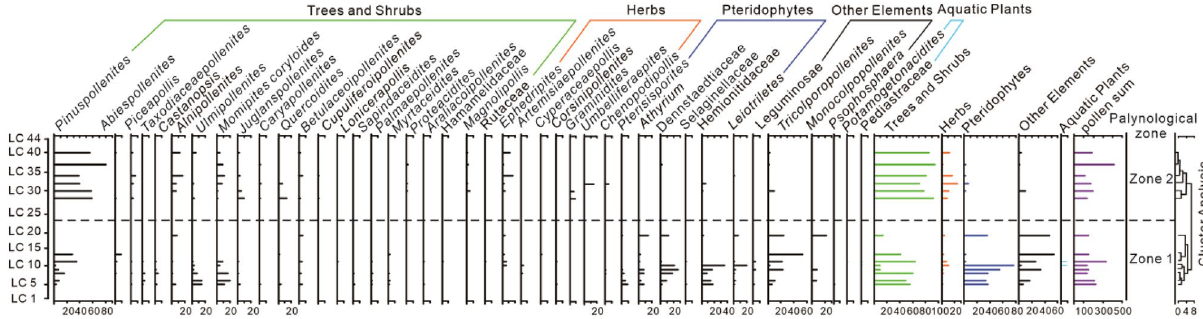
Figure 3. The percentages of pollen in the Luanchuan